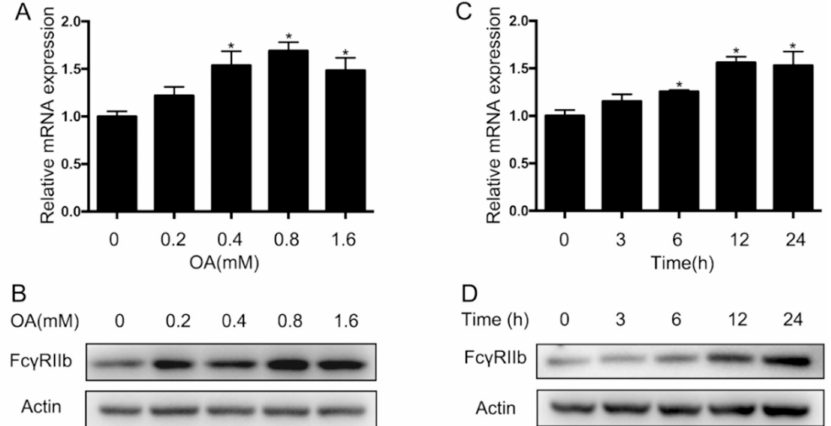
Figure 2. Fc γ RIIb expression and regulation in HepG2. ( A ) qRT-PCR for mRNA expression of Fc γ RIIb in HepG2 in response to the indicated doses of oleic acid (OA) for 24 h. ( B ) Western blot analysis for Fc γ RIIb expression under the same conditions as described in A. ( C ) qRT-PCR for mRNA expression of Fc γ RIIb in HepG2 cells in response to 0.4 mM OA treatment for indicated periods. ( D ) Western blot analysis for detecting Fc γ RIIb expression under the indicated conditions. The data shown are the means ± SEM. * p <